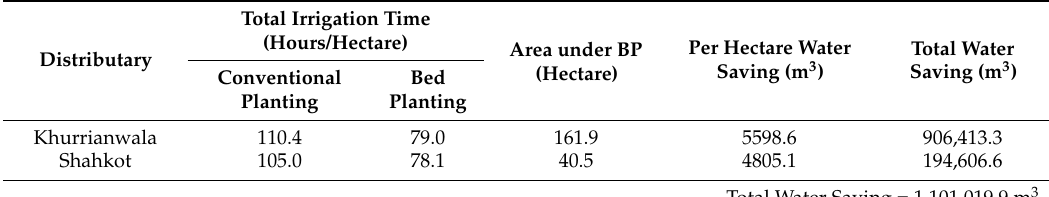
Table 7. Water savings from rice under bed-planted fields.